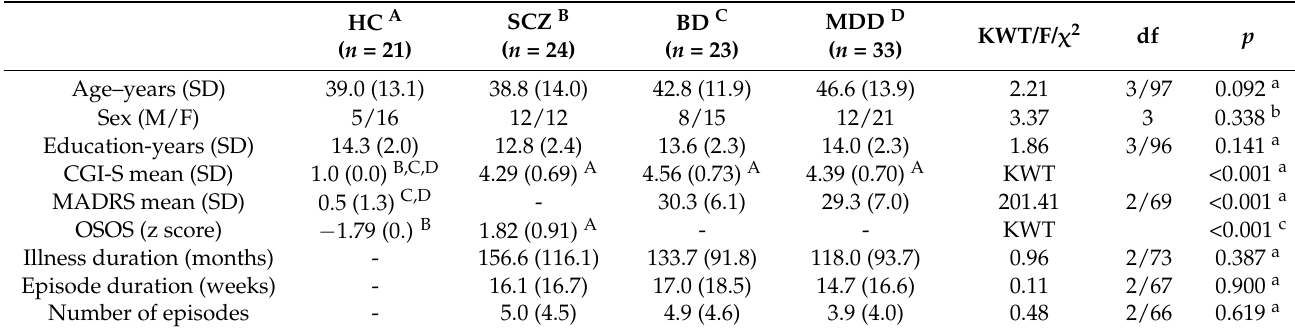
Table 1. Sociodemographic data.